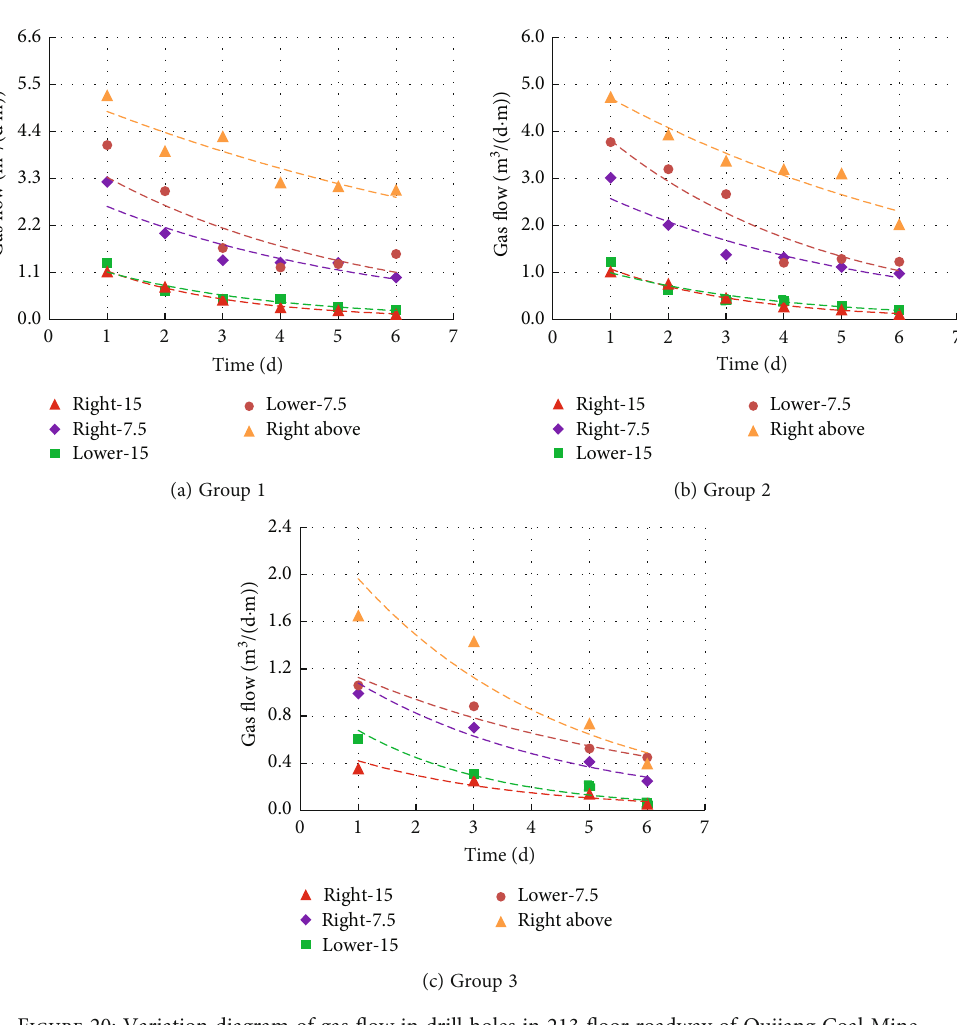
Figure 20: Variation diagram of gas fl ow in drill holes in 213 fl oor roadway of Qujiang Coal Mine.